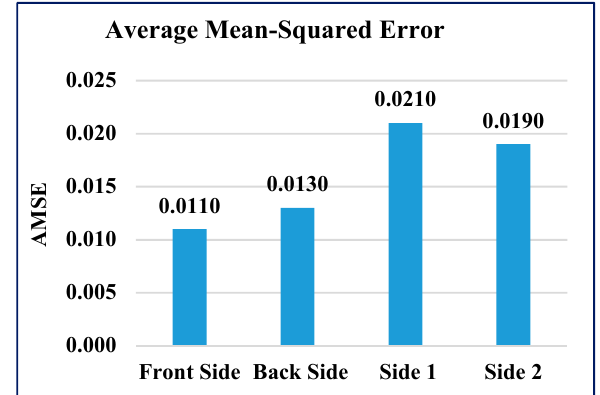
14 of 24 Figure 7. Data imputation models and performance comparison.